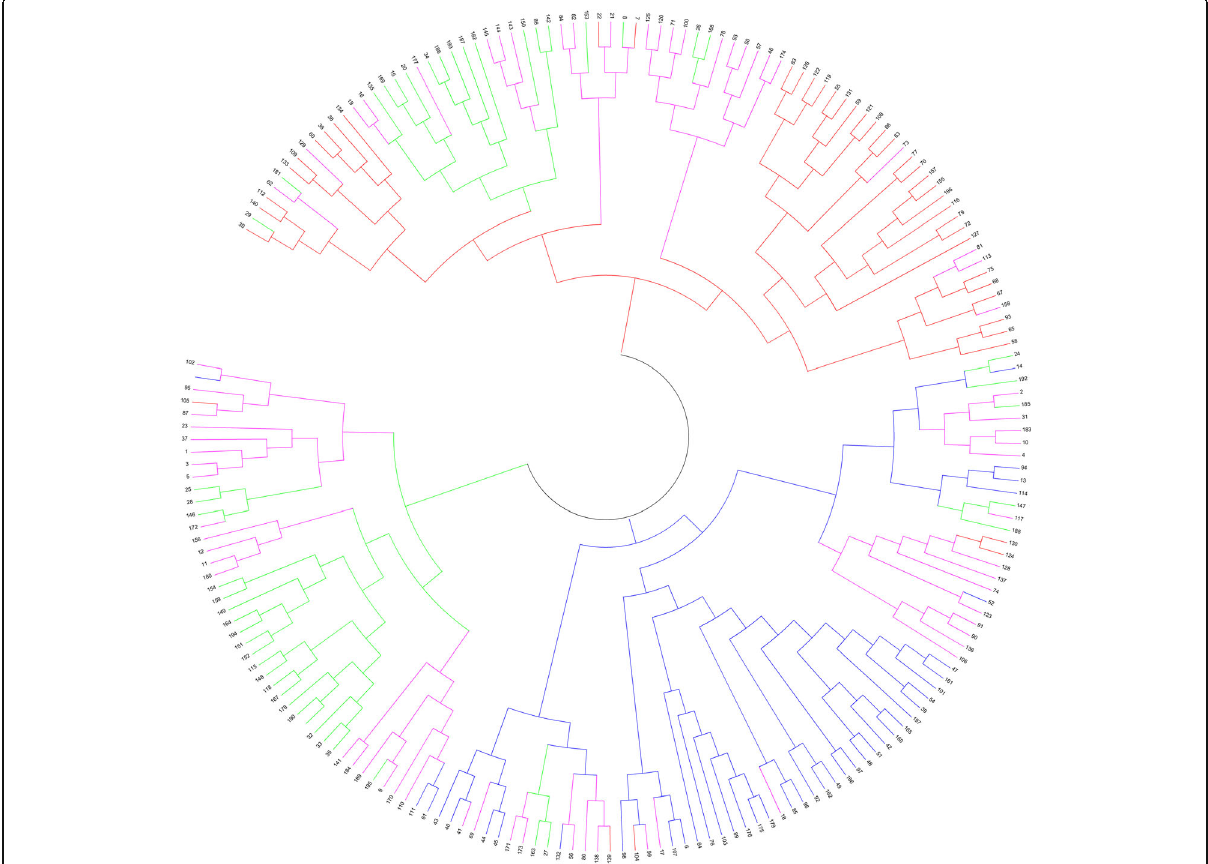
Fig. 3 Neighbor-joining tree of 197 Gossypium arboreum accessions. Colors in the tree correspond to subgroups identified in Structure analysis (Red for Group 1, Blue for Group 2, Green for Group 3, Purple for mixed